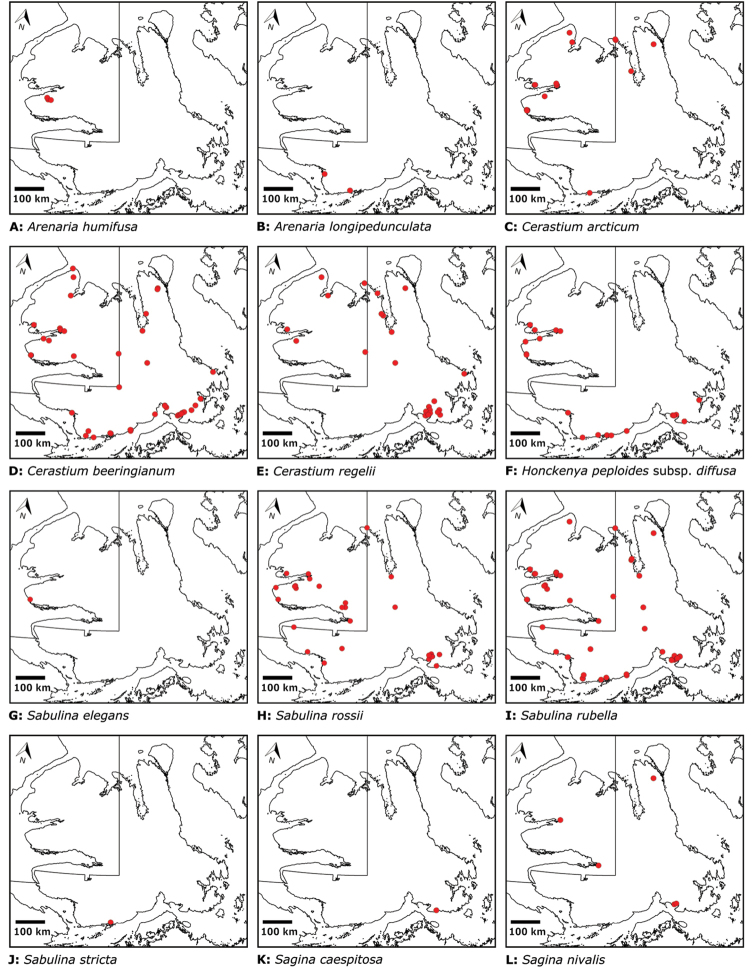
Species distribution maps. Caryophyllaceae: AArenaria
humifusaBArenaria
longipedunculataCCerastium
arcticumDCerastium
beeringianumECerastium
regeliiFHonckenya
peploides
subsp.
diffusaGSabulina
elegansHSabulina
rossiiISabulina
rubellaJSabulina
strictaKSagina
caespitosaLSagina
nivalis.